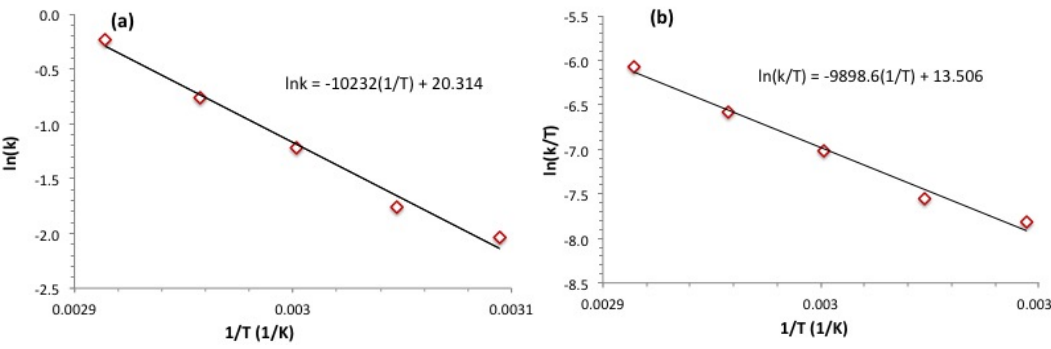
Figure 4. ( a ) Arrhenius plot, ( b ) Eyring plot for the dehydrogenation of dimethylamine borane starting with a solution containing 500 mM NH(CH 3 ) 2 BH 3 and 5.0 mM Ru(acac) 3 at different temperatures.